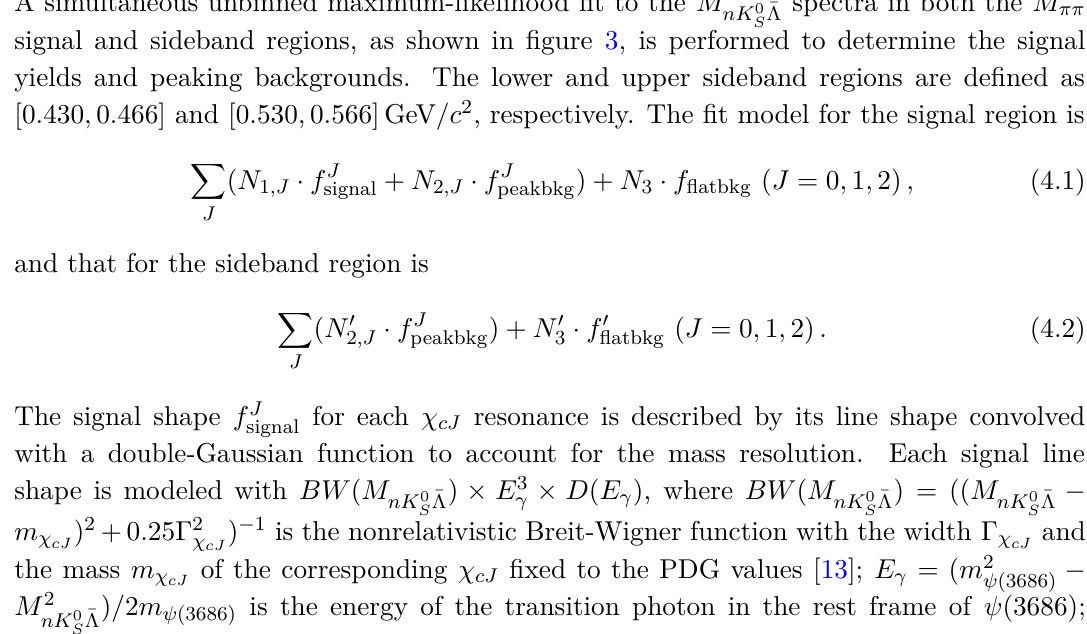
Figure 2 . Distributions of (a) M ππ of the K 0 M miss before the 1-C kinematic fit. Dots with error bars are data. Red solid (blue dashed) lines refer to the inclusive MC samples with (without) the signal processes. The pairs of pink solid (blue dashed) arrows indicate the signal (sideband)